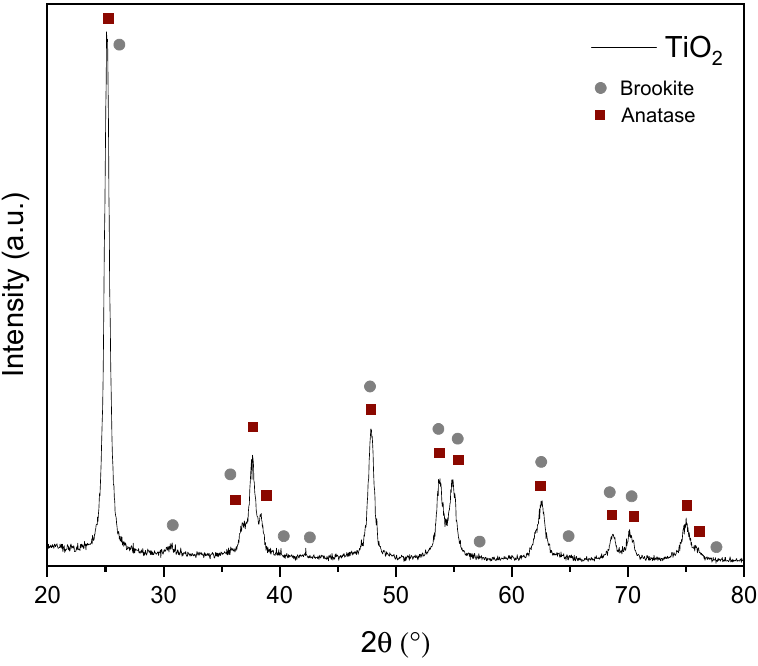
Figure 2. Diffractogram of the TiO 2 nanoparticles.